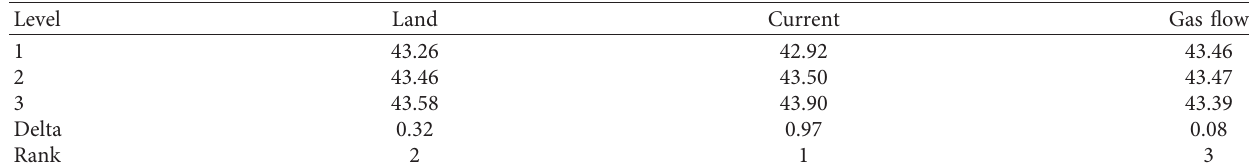
Table 16: Taguchi analysis (hardness: larger is better)—response table for signal-to-noise ratio. Level Land